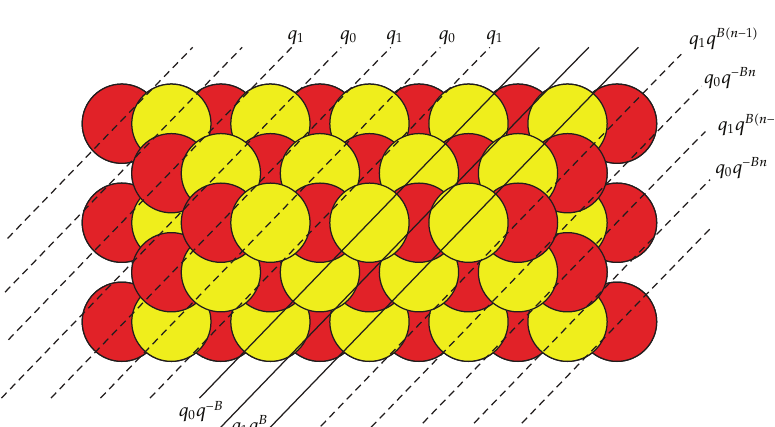
Figure 19: Refined pyramid crystal for the conifold, in the chamber corresponding to n stones in the top row. Along each slice (cid:4) as indicated by broken or solid lines (cid:5) , all stones have the same color, assigned as follows. On the left side (cid:4) along broken lines (cid:5) , each light (cid:4) yellow (cid:5) and dark (cid:4) red (cid:5) slice has color denoted q 0 and q 1 , respectively. Moving to the right, in the intermediate region (cid:4) along solid lines (cid:5) , a color of each new light or dark slice is modified by, respectively, q ∓ B factor (cid:4) with respect to the previous light or dark slice (cid:5) . On the right side (cid:4) again along broken lines (cid:5) , each light or dark slice has again the same color, respectively, q 0 q − Bn or q 1 q B (cid:4) n − 1 (cid:5) . The assignment of colors in the intermediate region (cid:4) along solid lines (cid:5) interpolates between constant assignments on the left and right sides of the